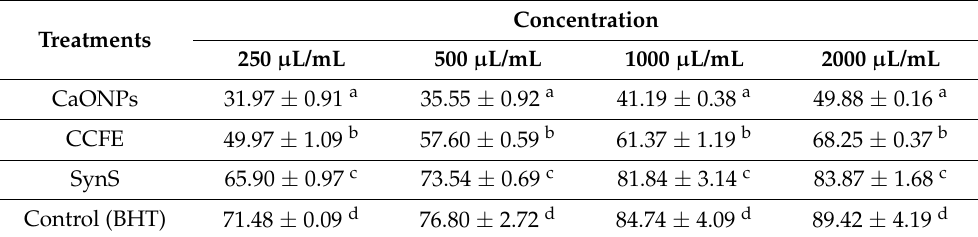
Table 3. Antioxidant activity of CaONPs, C. colocynthis fruit extracts, and their synergistic solution, by DRSA assay.